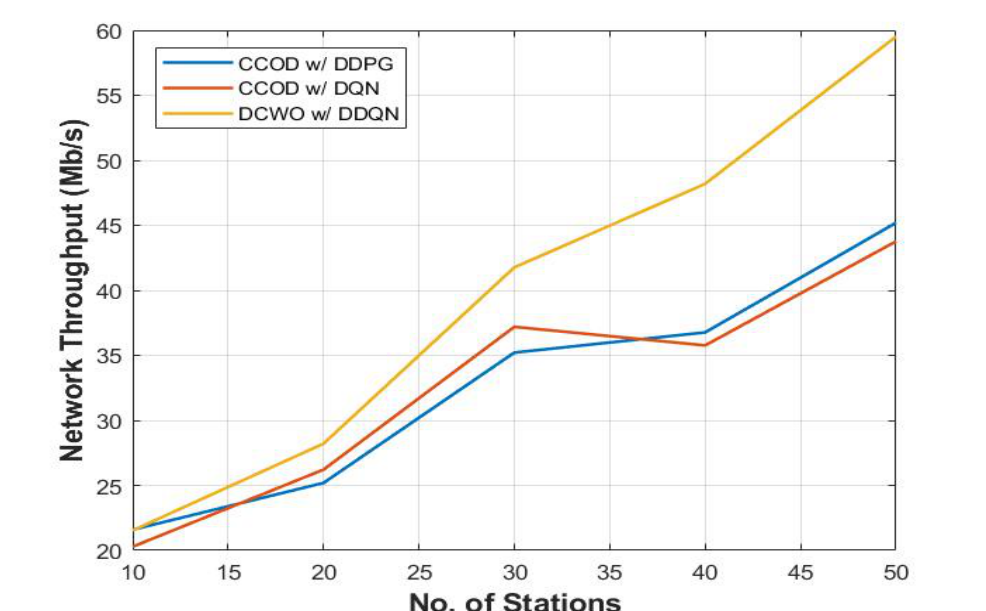
Figure 5. Network Throughput for Static